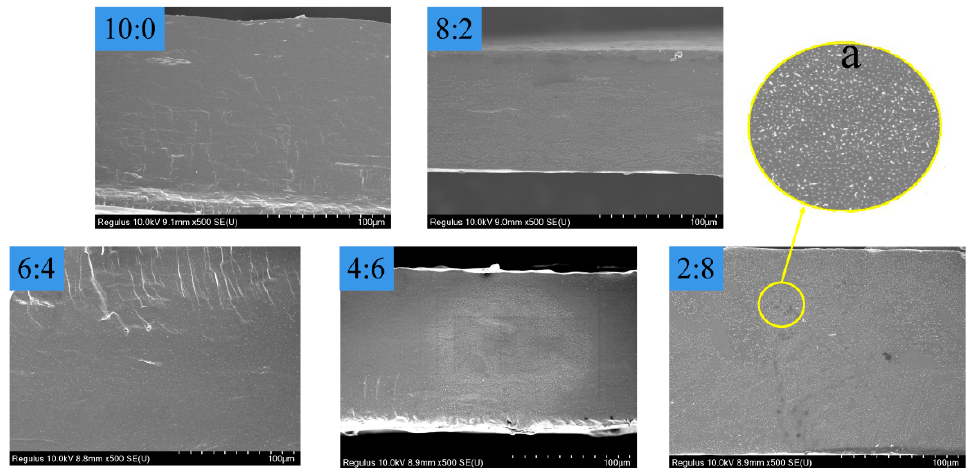
Figure 6. The SEM images of the composite films with different mass St/PL ratios. (a) Magnification ×10.